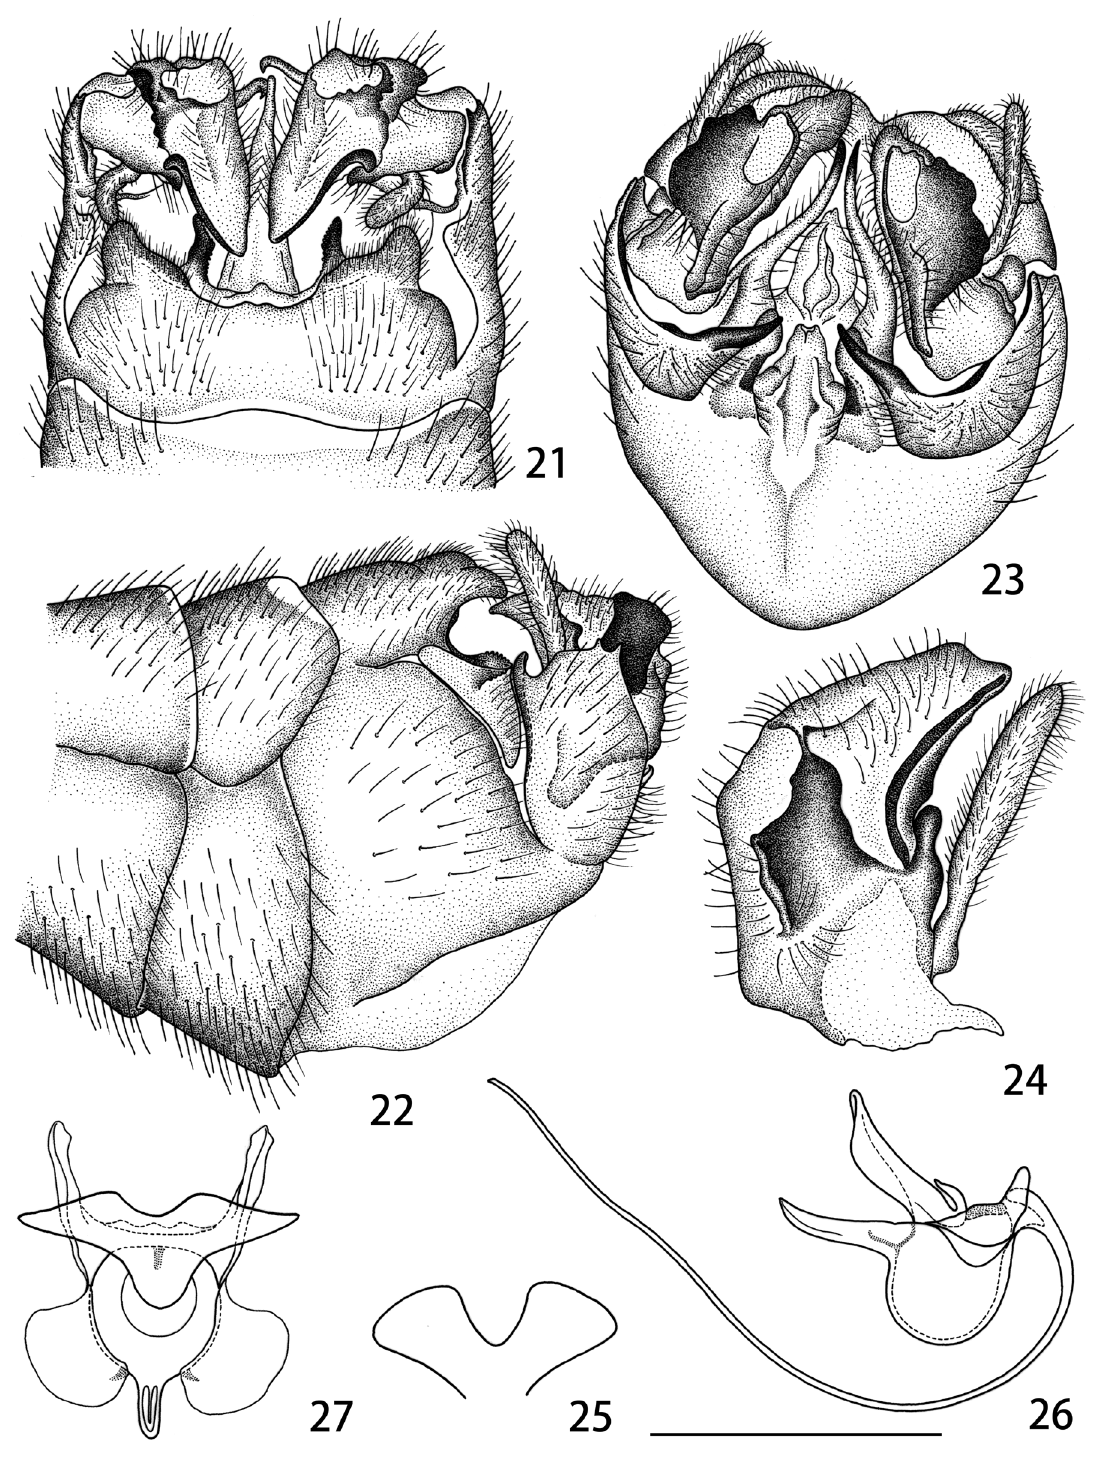
Figs 21–27. Tipula ( Vestiplex ) medialobata sp. nov., ♂ , holotype (coll. Inse-YN0501). 21 . Hypopygium, dorsal view. 22 . Hypopygium, lateral view. 23 . Hypopygium, ventral view. 24 . Right lobe and clasper of gonostylus, lateral view. 25 . Ejaculatory apodeme of semen pump. 26 . Semen pump, lateral view. 27 . Semen pump, dorsal view. Scale bars: 21–23 = 1.0 mm; 24 = 0.5 mm; 25–27 = 1.2